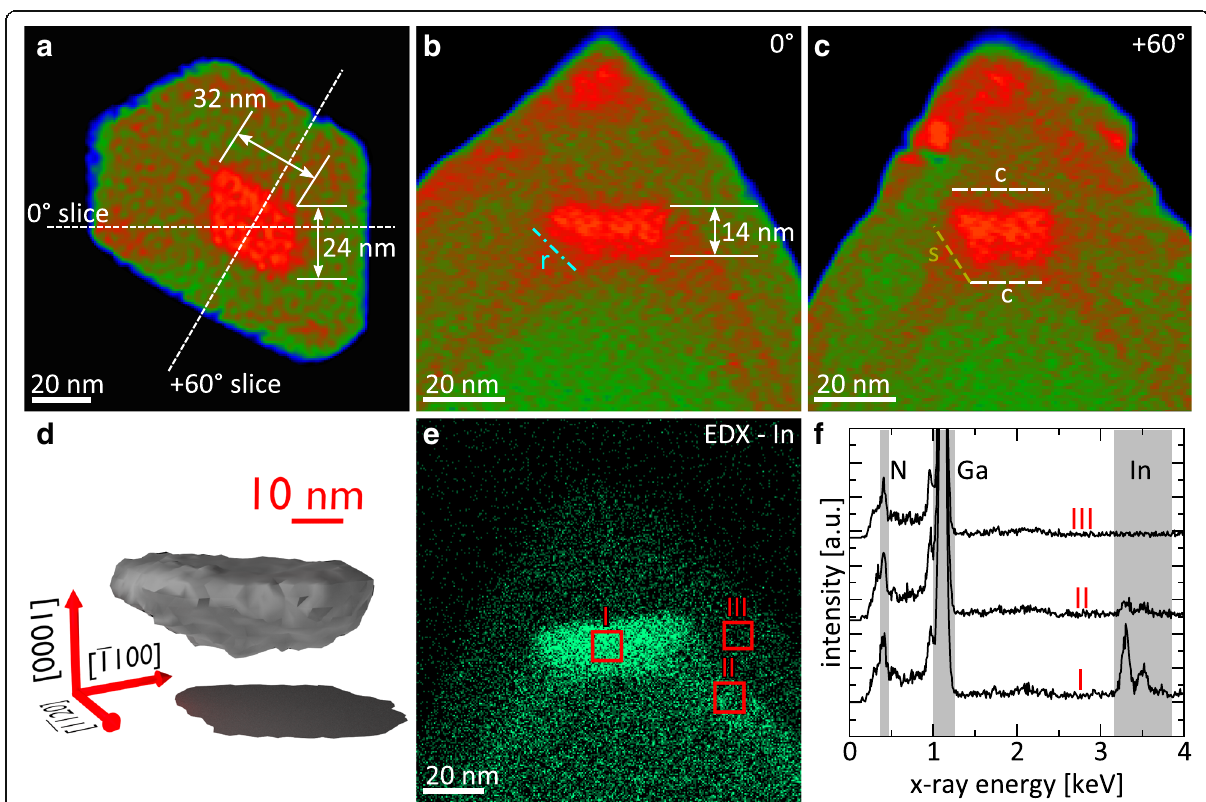
Fig. 6 Magnified a plan-view and b , c cross-sectional tomographic slices of Figs. 4 and 5 revealing the morphology of the dot-in-a-wire structure. d 3D isosurface representation of the (In,Ga)N dot. The EDX measurements at a similar NW tip are presented in form of e an EDX map showing the spatial indium distribution and f an EDX spectra extracted from the map at three different regions: (I) in the (In,Ga)N dot, (II) in the (In,Ga)N shell, and (III) in the GaN outer